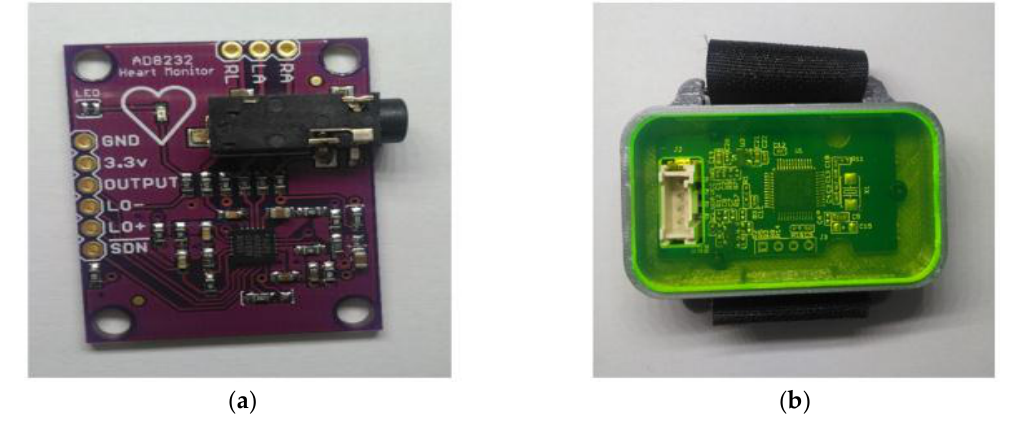
Figure 2. Optical biosensors: ( a ) electrocardiogram (ECG) heart-monitoring sensor; ( b ) finger-clip heart rate sensor.